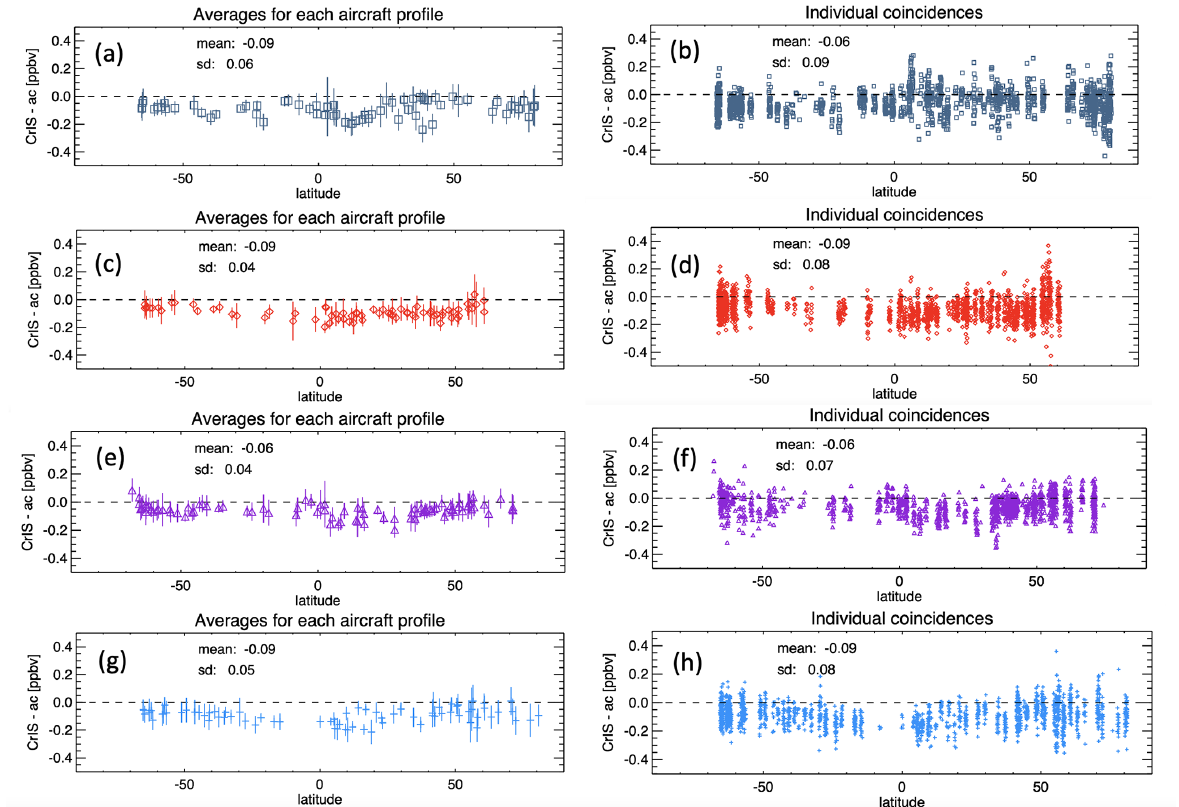
Figure 7. CrIS–PANTHER PAN differences against latitude for the four ATom aircraft campaigns. Results from ATom-1 are shown in panels (a) and (b) , ATom-2 in (c, d) , ATom-3 in (e, f) and ATom-4 in (g, h) . Panels (a) , (c) , (e) and (g) show the results after averaging all the CrIS coincidences for each aircraft profile. Vertical bars on the points in these panels show the standard deviation of the averaged CrIS result for each aircraft profile. Panels (b) , (d) , (f) and (h) show the results for individual CrIS soundings (multiple CrIS coincidences with each aircraft